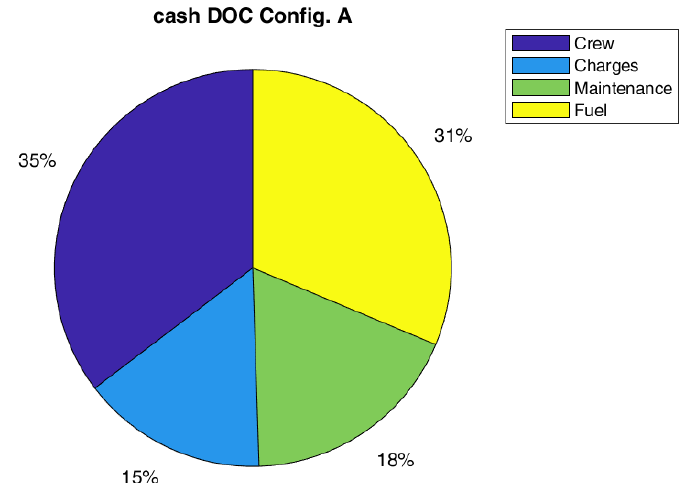
Figure 9. Pie chart of cash DOC for Config. A (SM = 2.0, with SHM).